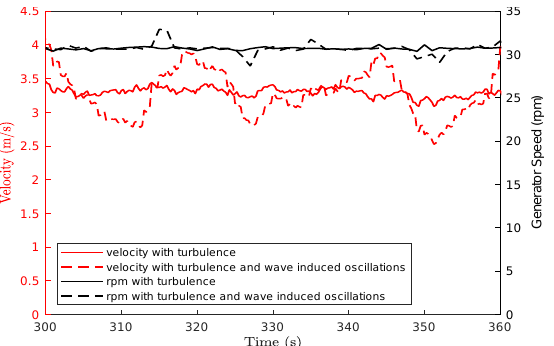
Figure 25. Variation of generator speed as a function of change in tidal stream velocity in a pitch- controlled turbine. Compare this with the generator speed variations in Figure